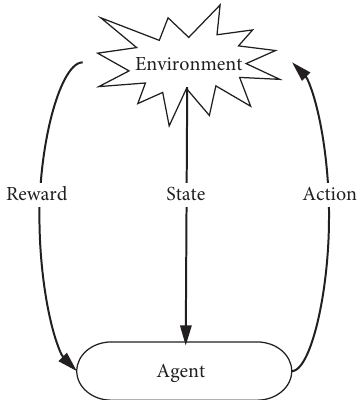
Figure 1: Reinforcement learning explanatory diagram.